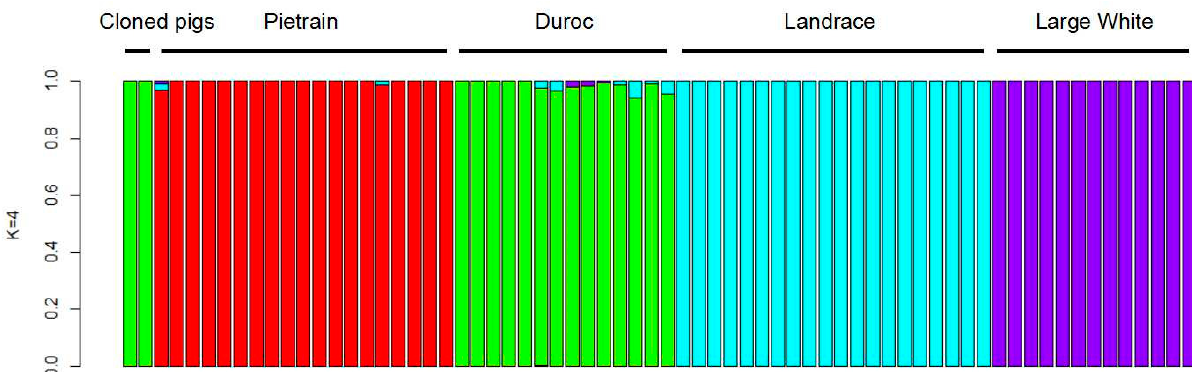
Figure 4. Results of admixture analysis for breed tracing of cloned pigs. Four pig breeds were illustrated with different colors. Each bar represents an individual pig and values on the Y axis represent the proportions of ancestry.